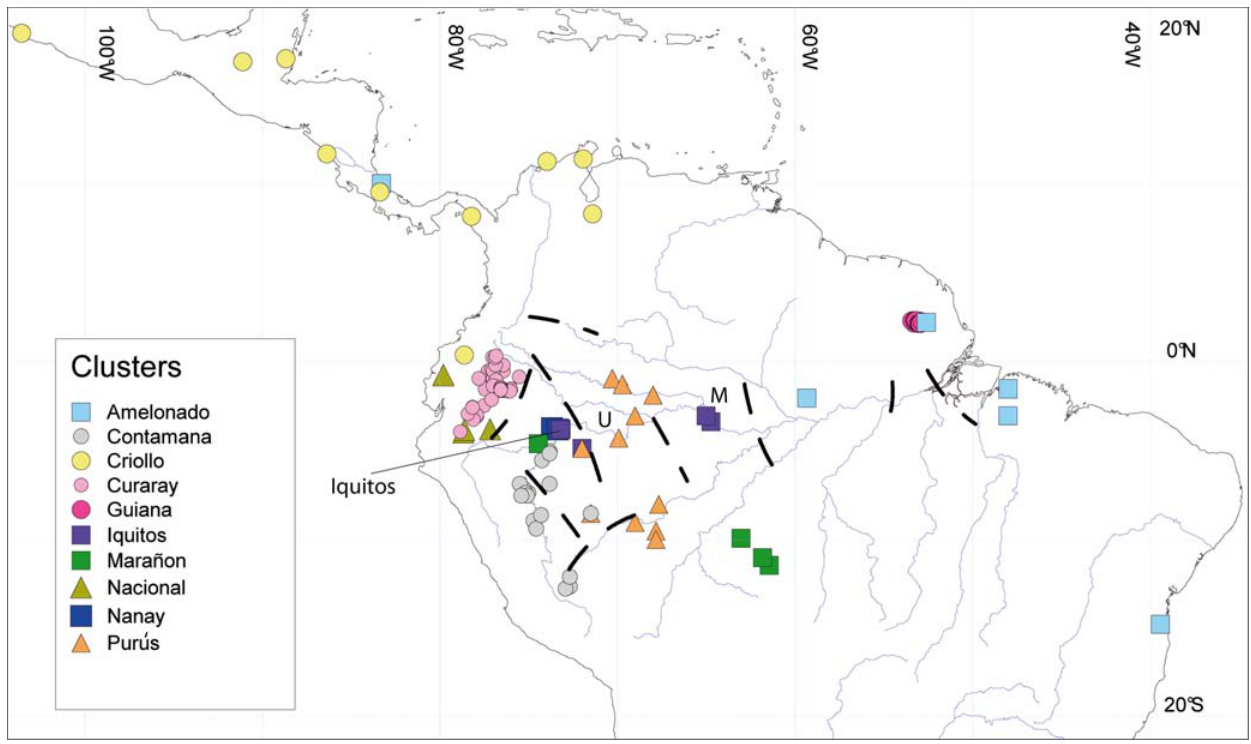
Figure 1. Localization of the origin of individuals analyzed; colors indicate the inferred genetic cluster to which they belong. Approximated location of Amazon ancient ridges (‘‘palaeoarches’’) is shown, after [26], in order of apparition clockwise: Fitzcarrald, Maran˜on, Serra